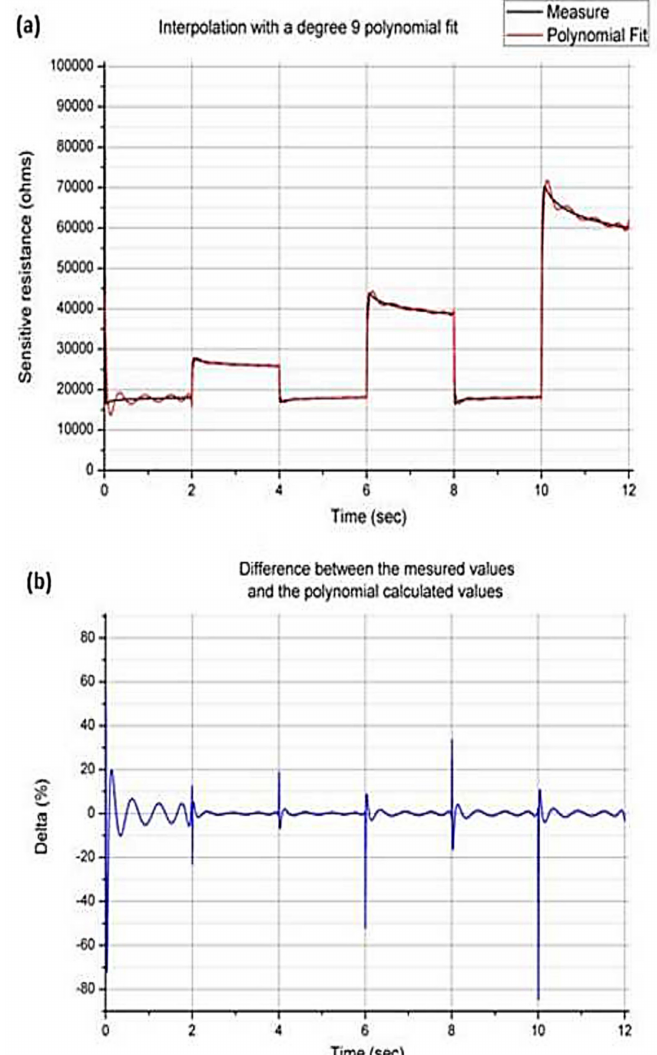
Figure 5. Comparison between the sensor’s response and the polynomial modeling ( a ) and difference between both ( b ).